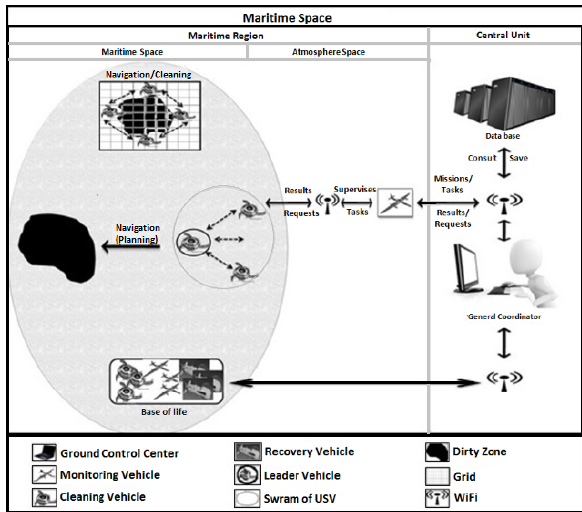
Figure 1: Hybrid architecture of the